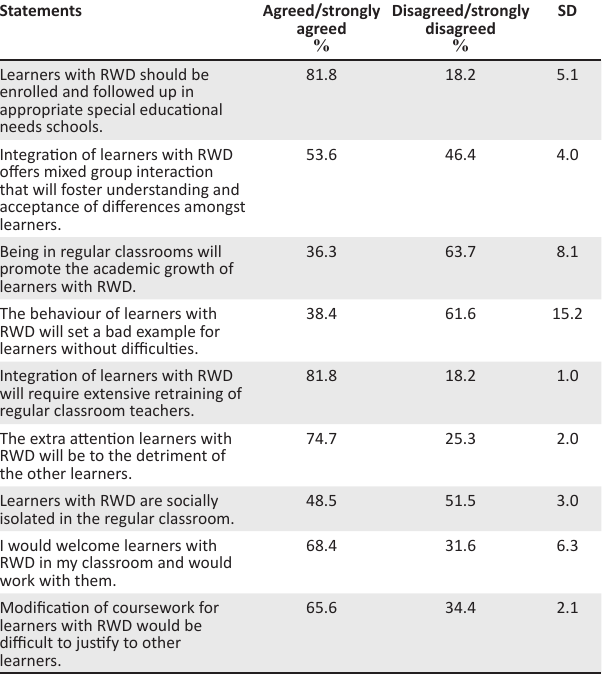
TABLE 4: Participants’ perspectives learners with reading and writing difficulties in inclusive education.